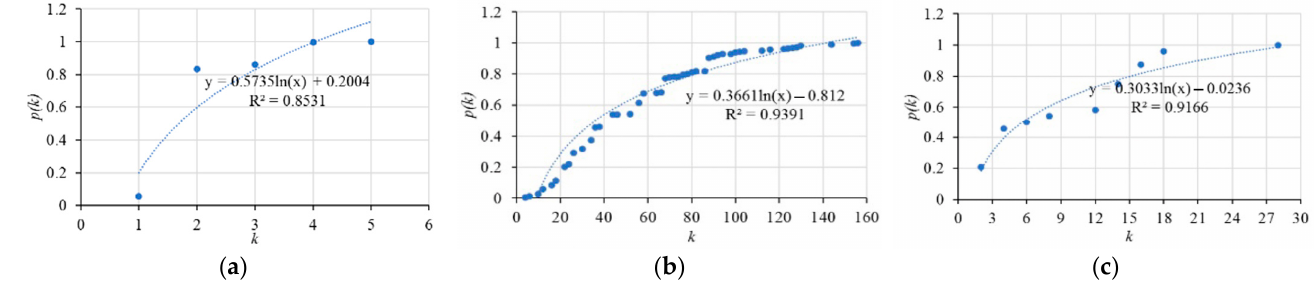
Figure 4. Fitting curve of cumulative distribution for the degree of Beijing subway networks. ( a ) Space L network. ( b ) Space P network. ( c ) Space C network.